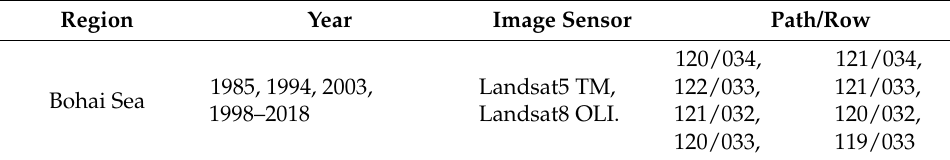
Table 1. List of land satellite image data of Bohai